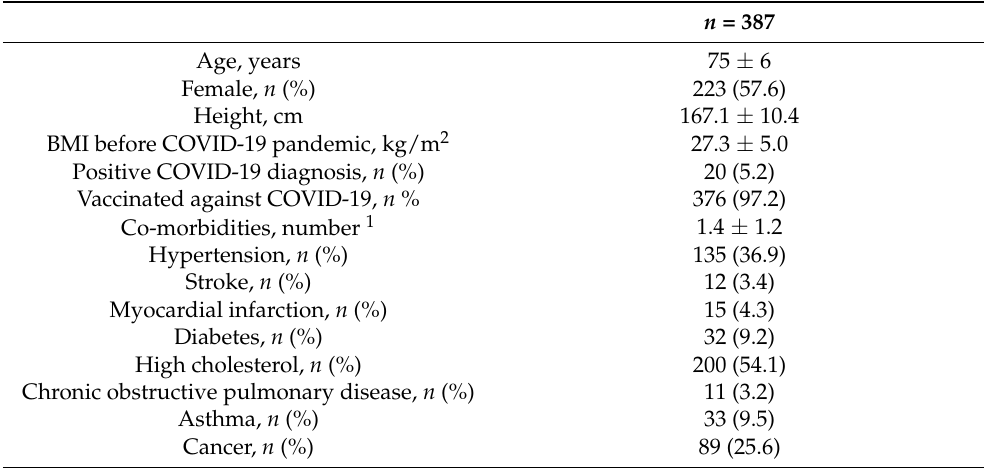
Table 1. Demographic and clinical